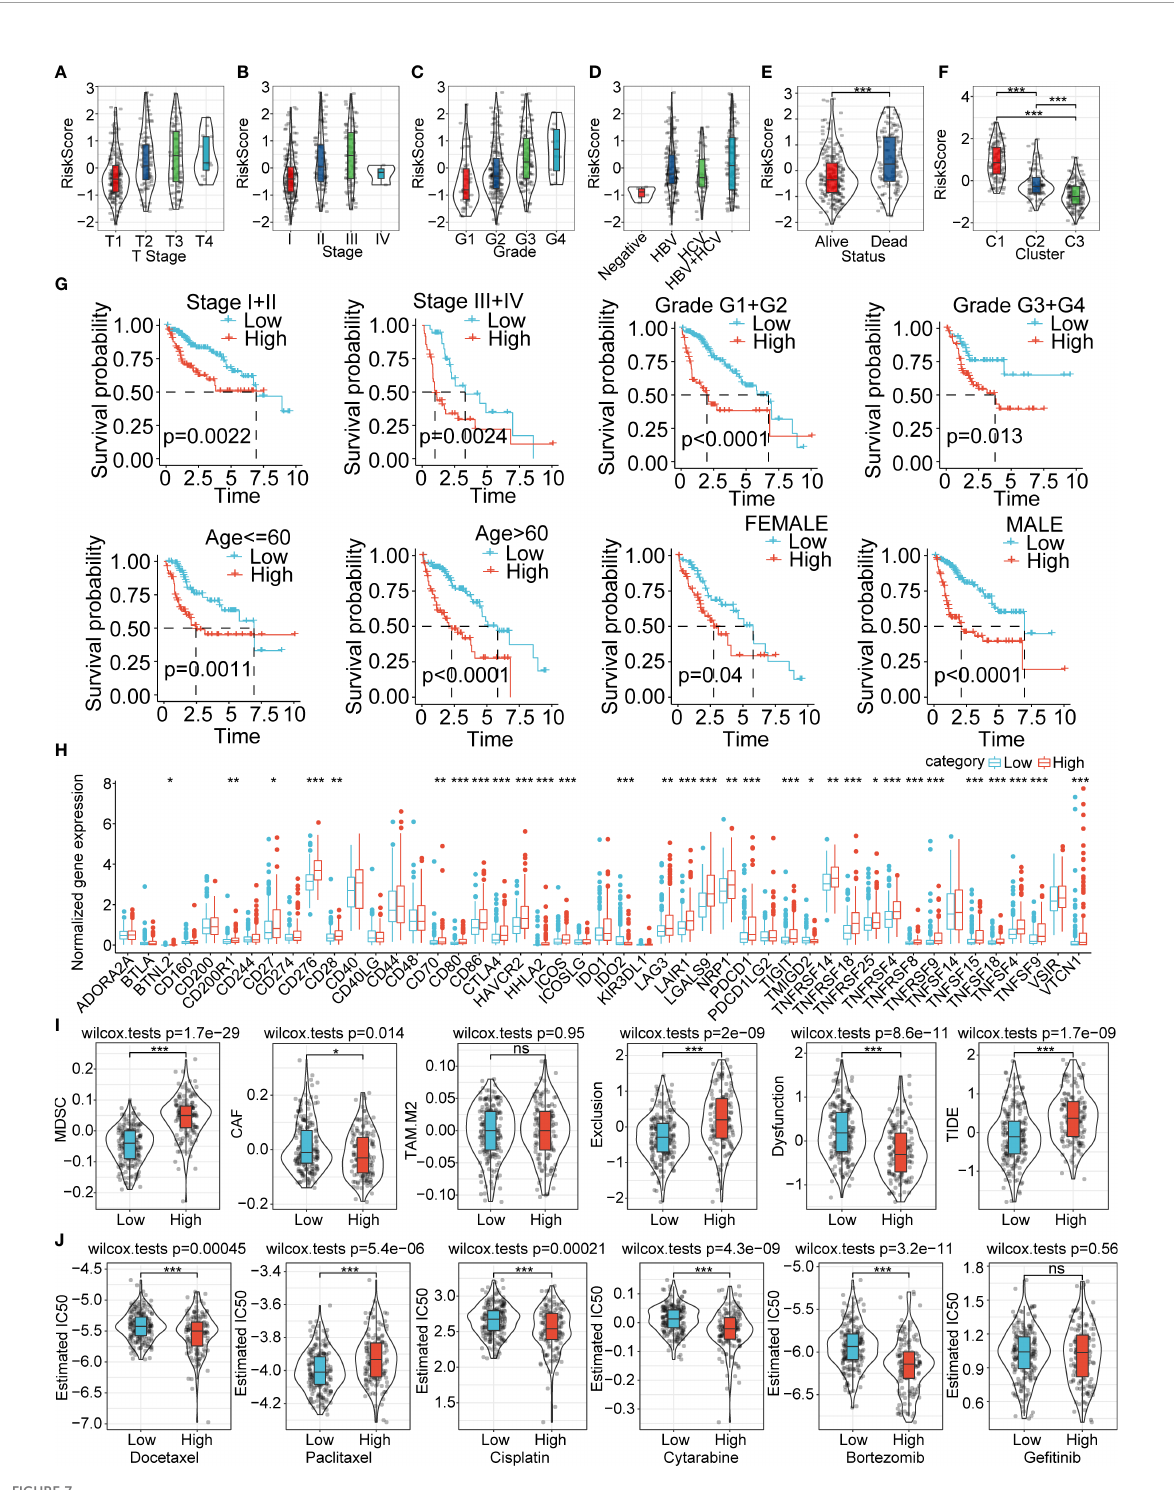
FIGURE 7 Clinical features, prognosis prediction, expression of immune checkpoint genes, immune in fi ltration score evaluation, and therapeutic response between the high and low risk-score subgroups (A − F) . Risk score difference between the various clinical feature backgrounds (G) . Overall survival prognosis difference between the high and low risk-score subgroups under different clinical backgrounds (H) . The immunological checkpoints genes were differentially expressed between the high and low risk-score subgroups in the TCGA-LIHC cohort (I) . Difference in TIDE score evaluation between the high and low risk-score subgroups in the TCGA-LIHC cohort (J) . Box plots of the estimated IC50 for docetaxel, paclitaxel, cisplatin, cytarabine, bortezomib, and ge fi tinib between the high and low risk-score subgroups in TCGA-LIHC. *P<0.05; **P<0.01; ***P<0.001; ns, not signi fi